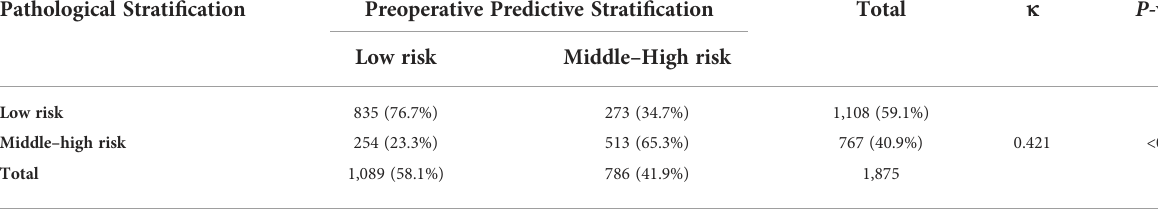
TABLE 5 Consistency check of the grouping results based on postoperative pathology and the preoperative predictive